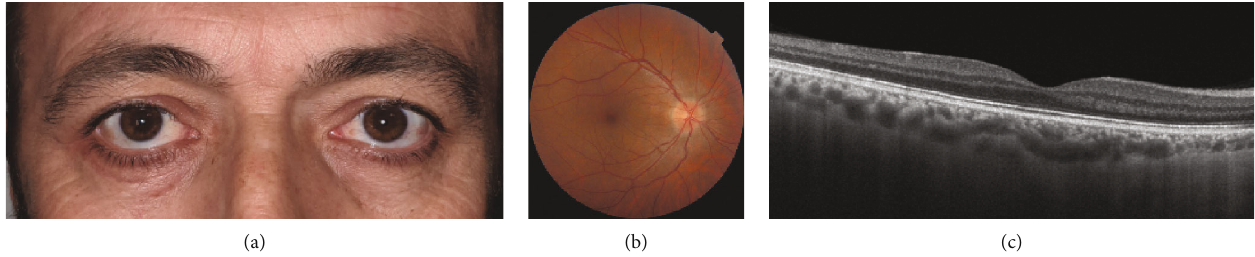
Figure 4: (a) Clinical appearance of the patient one month after orbitotomy showing that the right inferotemporal orbitotomy skin incision has nicely healed. (b) Fundus photograph shows signi fi cant resolution of optic disc edema and no macular compression. (c) Swept-source optical coherence tomography shows complete resolution of dome-shaped maculopathy-like